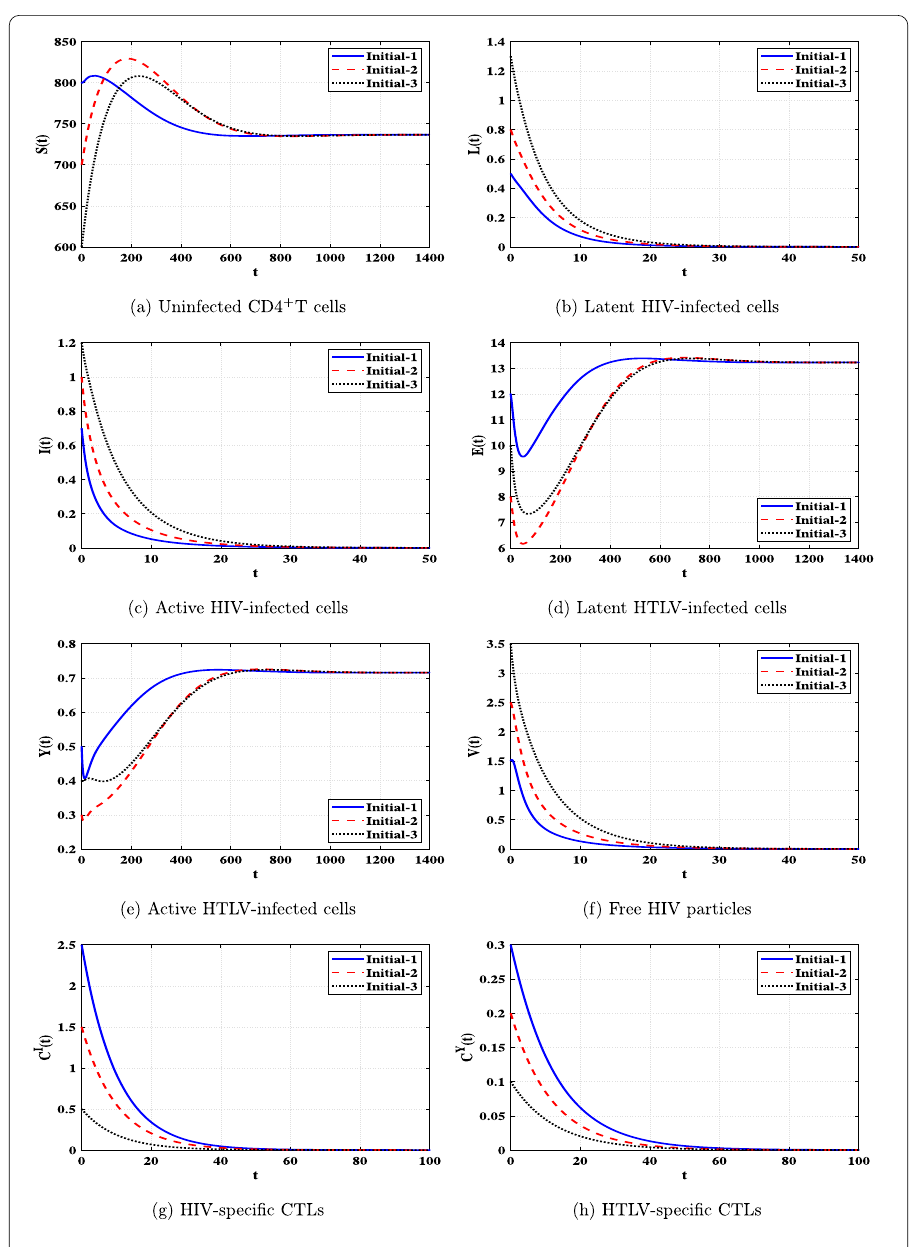
Figure 3 Solutions of system (29) when (cid:9) 2 > 1, (cid:9) 1 / (cid:9) 2 ≤ 1, and (cid:9) 4 ≤ 1